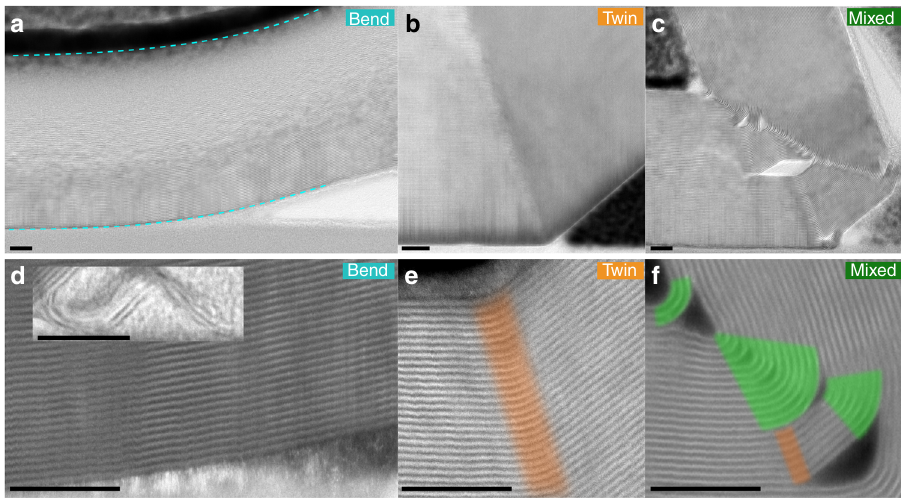
Fig. 3 HAADF STEM images of different bending phenomena in graphite. a – c Bright fi eld STEM images showing the microstructure of graphite for each bending mode: Bend, Twin and Mixed modes. The bend angle and number of basal planes in the crystal thickness for each are θ = 12°, N 1 = 114 basal planes; θ = 40°, N 1 = 559; and θ = 115°, N 1 = 107, respectively. d – f HAADF STEM images demonstrating the different ways vdW crystals modify the arrangement of basal planes to accommodate strain induced by bending. The inset in d shows a 95° bend angle in a graphene bilayer. Areas of discrete twin boundaries are highlighted orange and areas of nanotube-like curvature are highlighted green. The mixed bending mode exhibits multiple discrete twins converging on a region of nanotube-like curvature and is only observed for the largest bend angles. All scale bars 5 nm